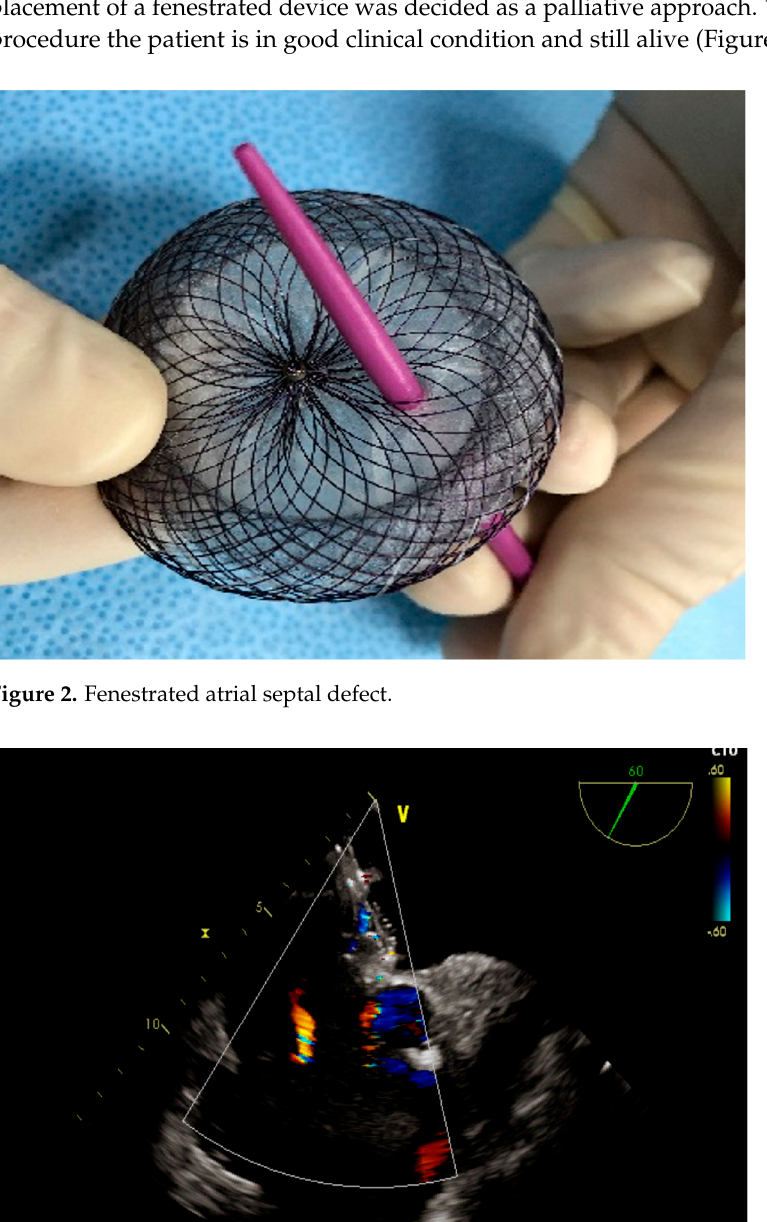
Figure 1. Apical four chambers view showing a very dilated right ventricle and severe tricuspid valve regurgitation. The interventricular septum bulged toward the left ventricle (panel A ). The RVSP was significantly increased (panel B ).